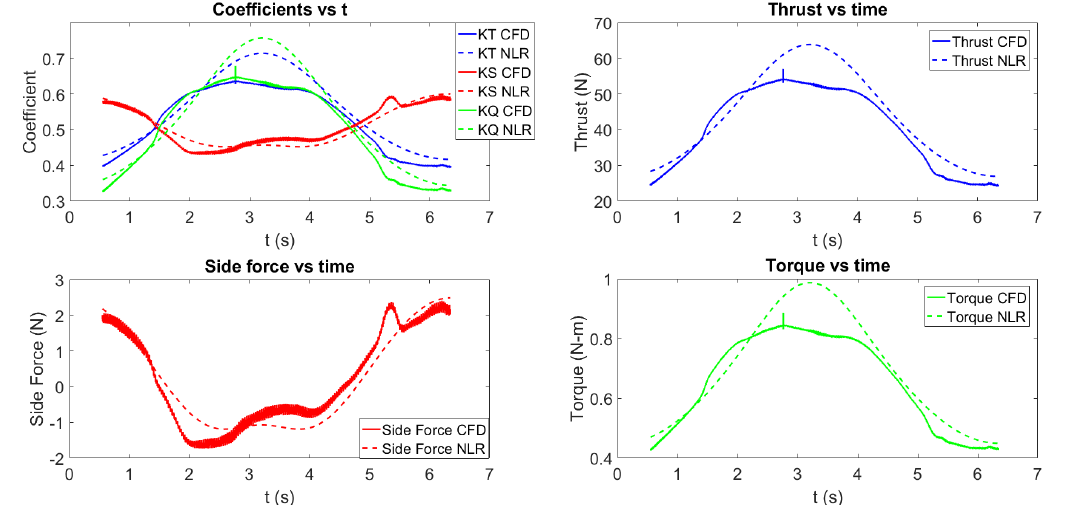
Figure 24. Behind condition coefficients, thrust, and torque for Test 3 as a function of time predicted by nonlinear